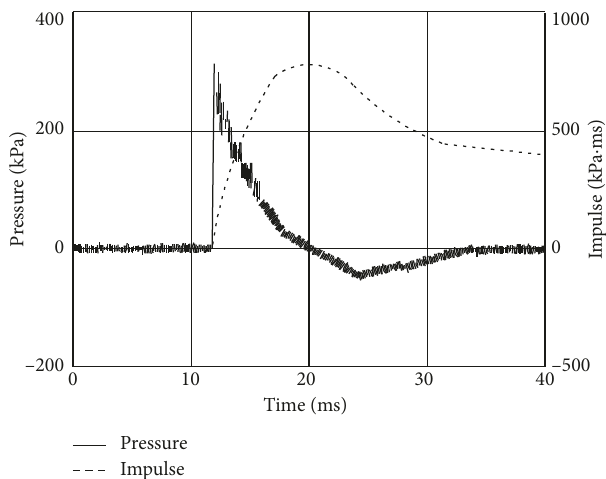
Figure 10: A typical reflected pressure time history obtained in shot 1.